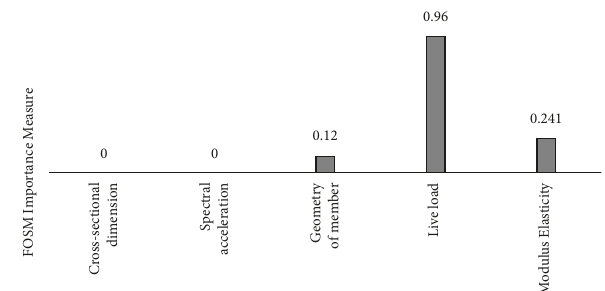
Figure 14: Scale diagram of the significance of type IV frame uncertainties in the FOSM method.